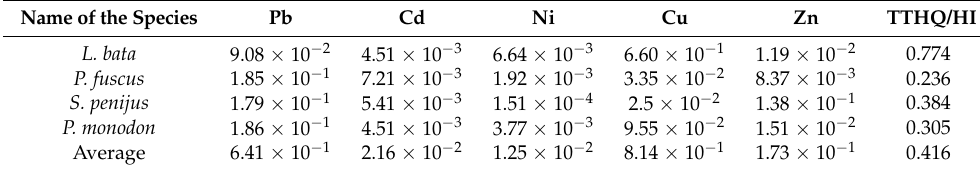
Table 4. THQ values of fish and